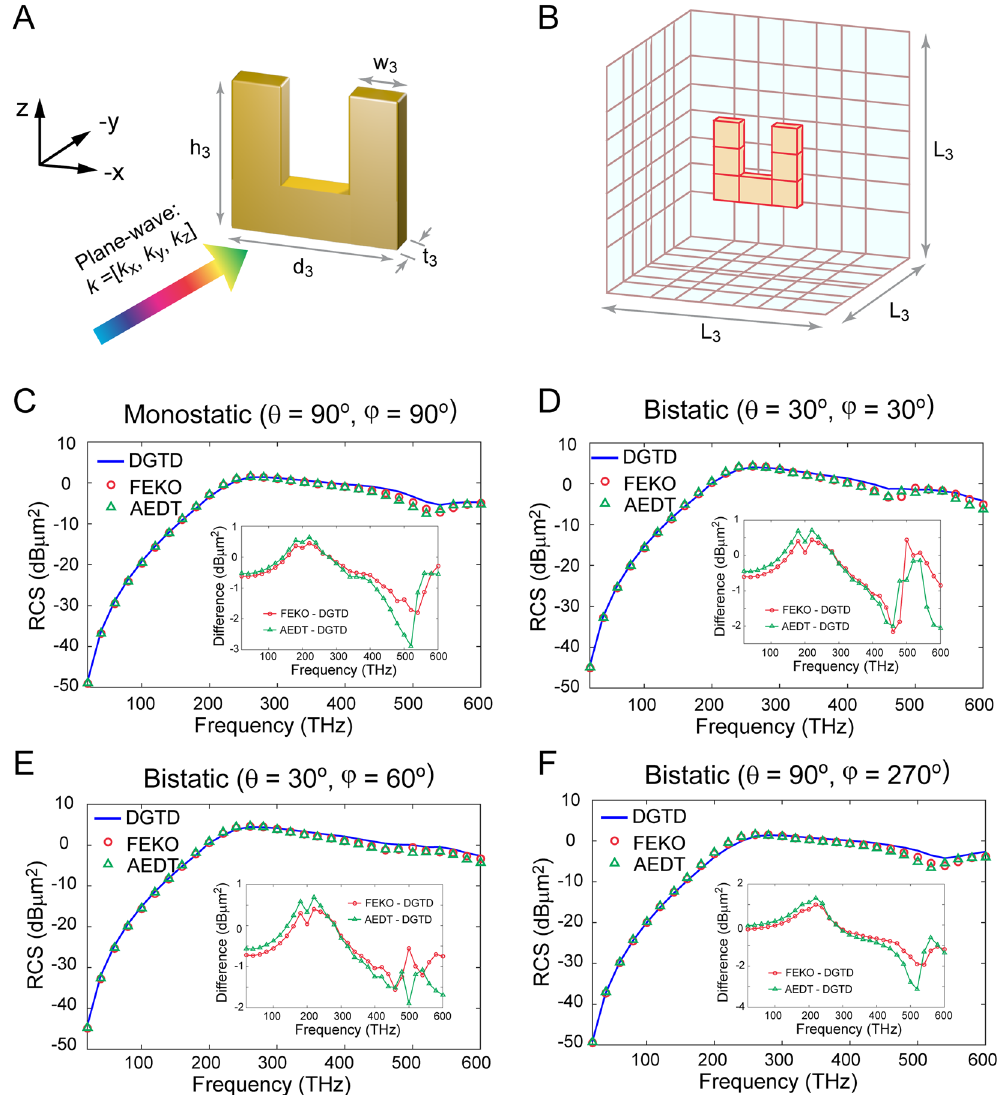
Figure 3. Geometry, mesh and results of SRR case. ( A ) The center of the DCP gold SRR is located at the origin. d respectively. ( B ) High order hexahedron mesh of physical region (the gold SRR and its surrounding space) with L